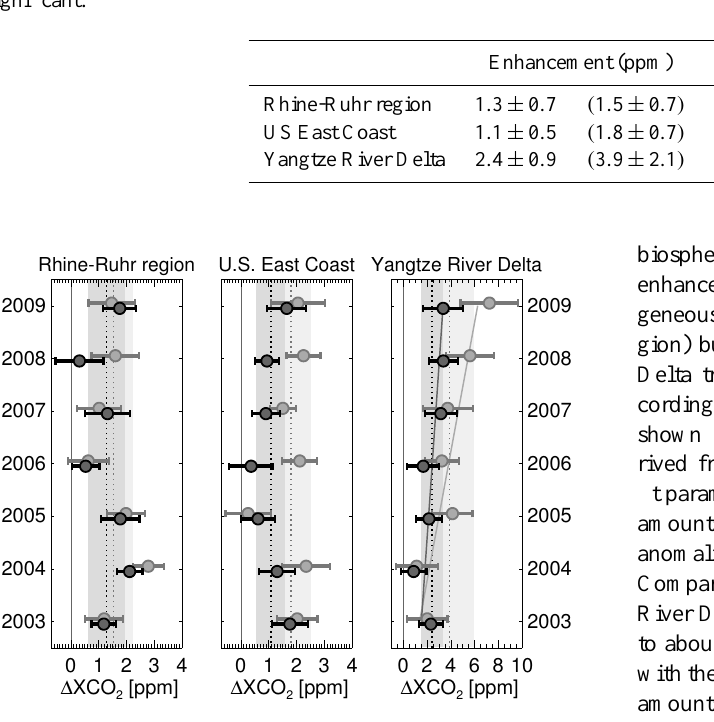
Table 2. Retrieved enhancements (with 1 σ error) and corresponding trends for the discussed source regions relative to the respective reference regions for the biospheric corrected anomalies and the original data set (numbers in brackets). Estimates shown in italic are statistically not significant.